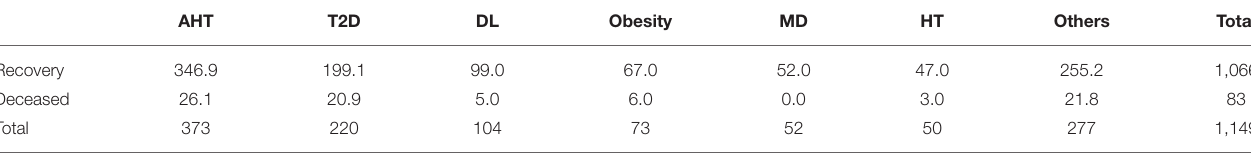
TABLE 4 | Main types of comorbidities and their relationship with recovery or death from COVID-19 disease ( n ). AHT